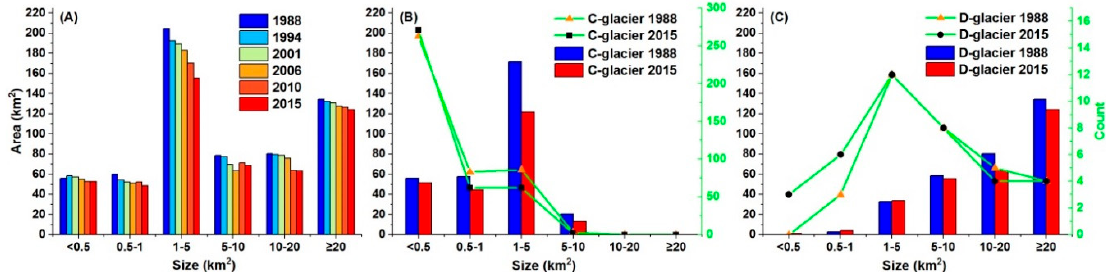
Figure 4. Area and frequency of glaciers in various size classes: ( A ) glacier total areas in the studied six years; ( B ) C-glaciers in 1988 and 2015; ( C ) D-glaciers in 1988 and 2015. Glacier numbers are given in green.